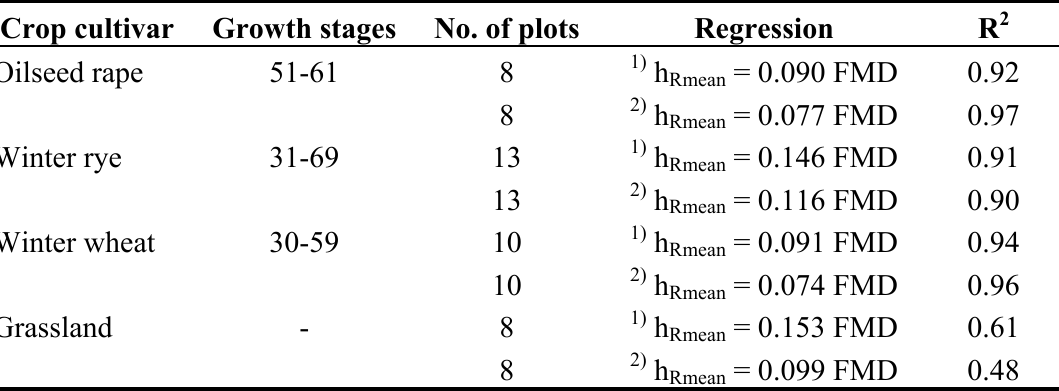
Table 1. Coefficients of determination for the relationship between crop biomass density and mean reflection height for small ranges < 2.50 m [2]